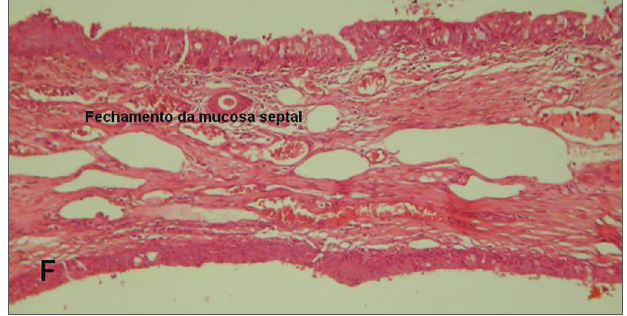
Figura 8. Fotomicrografia de lâminas histológicas de septo F=Septo íntegro reepitelizado. (10x). Coloração